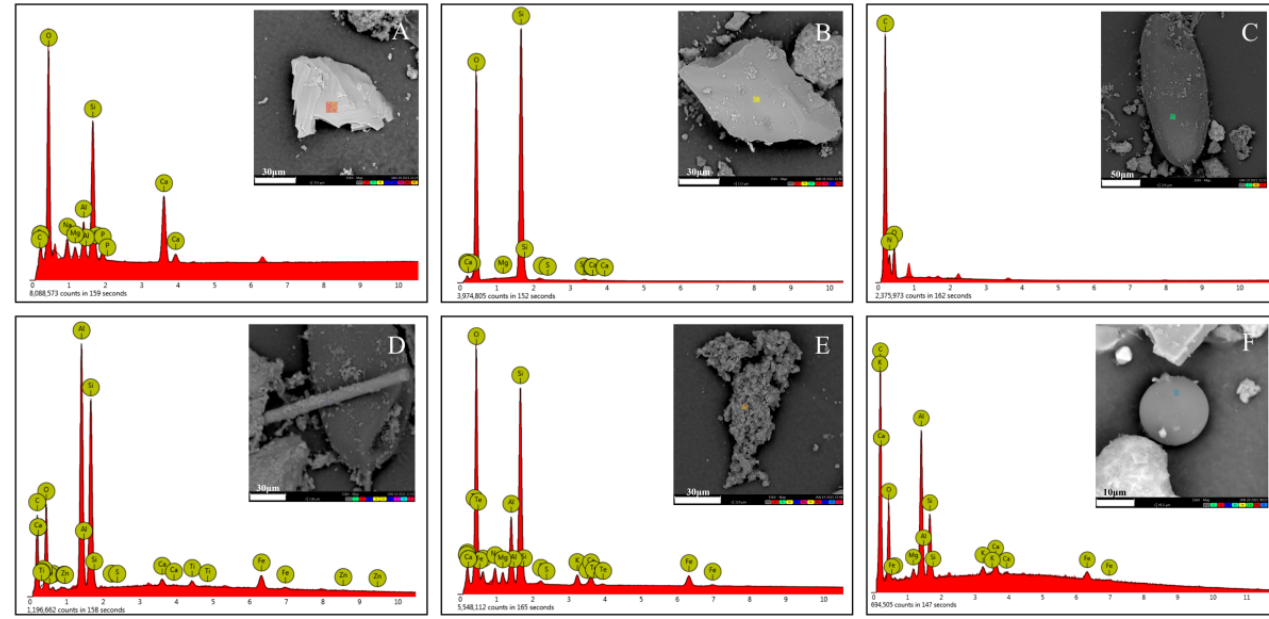
Figure 1. Morphology and energy spectrum of single particle retained by